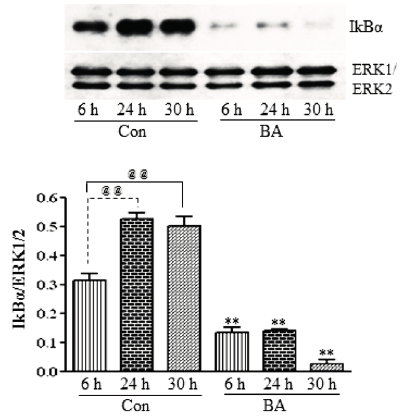
Figure 8. Butyrate inhibits IkB α protein expression in VSMC. Cells were exposed to 5 mM butyrate for the required periods of time and then processed for western analysis, as described in the Experimental Section, to evaluate the effect of butyrate treatment on IkB α protein expression by using anti-IkB α antibody ( top ). Band intensities are normalized to ERK1/ERK2 and displayed as a bar graph ( bottom ). Values shown are the mean ± SD of three independent